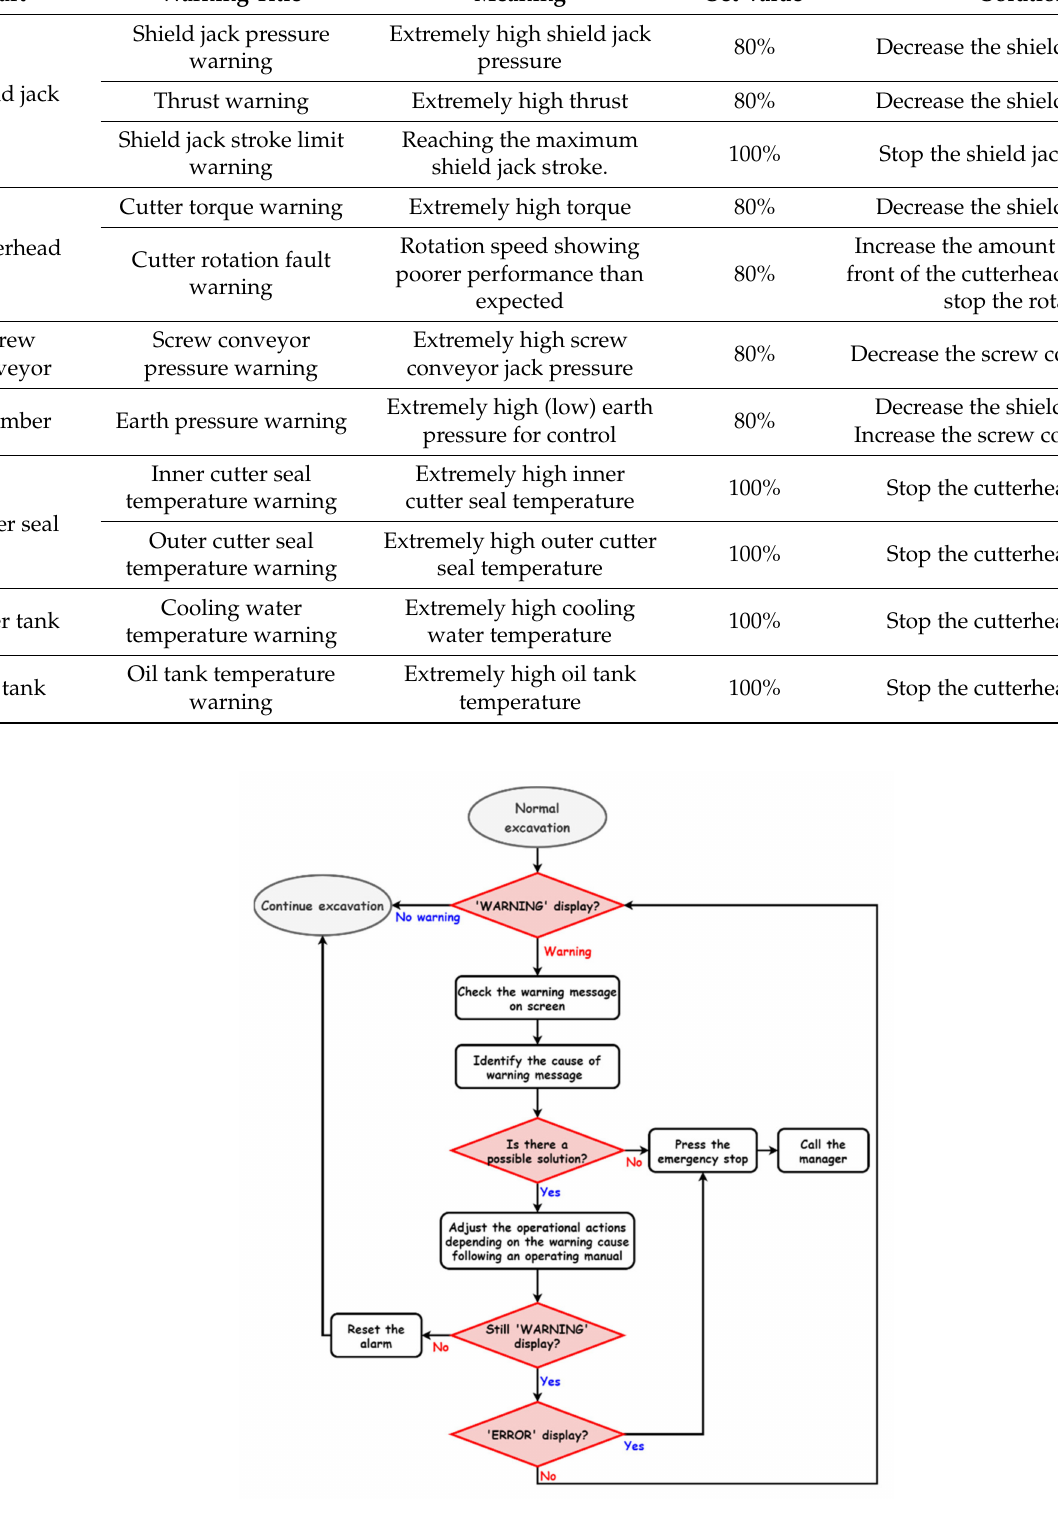
Figure 6. Procedure for resolving a warning in the TBM